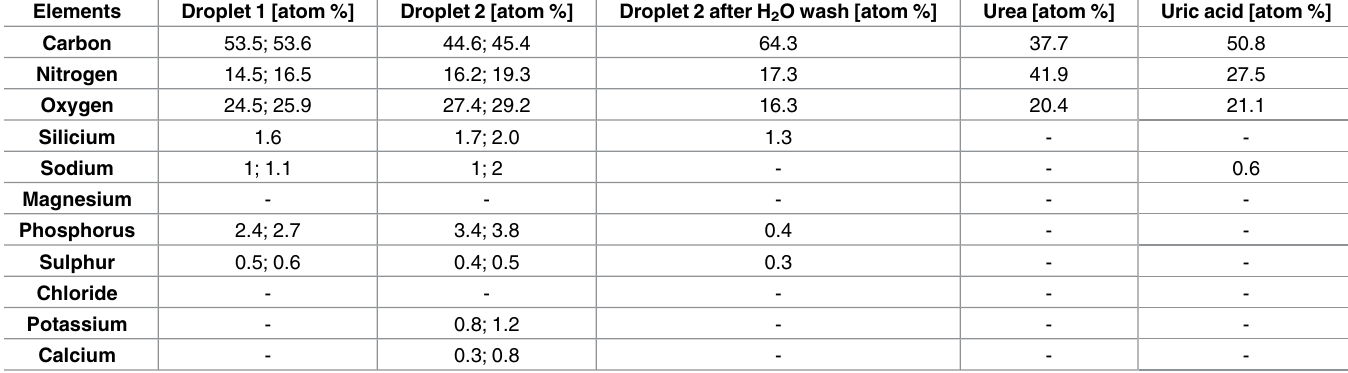
Table 4. Surface concentrations, given in atomic%, obtained by XPS investigations probing the composition within the topmost 0.01 μ m of dry fishing lines in A . luminosa and a urea powder characterised for reference purposes. Elements